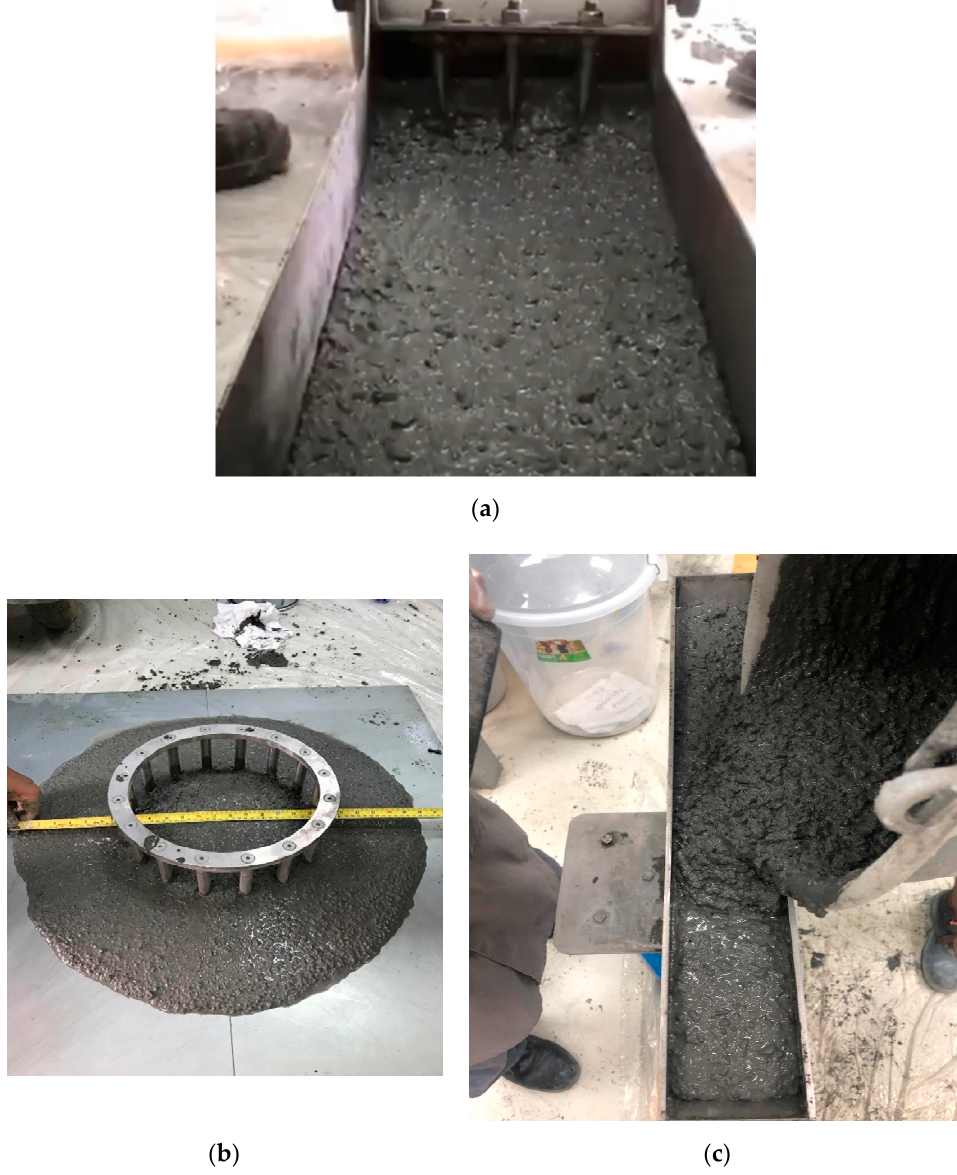
Figure 1. Photographs showing the tests performed on fresh self-consolidating concrete (SCC) samples: ( a ) Fresh SCC flowing through the L-Box; ( b ) Measuring the fresh SCC’s spread during the J-Ring test; ( c ) Filling the V-Funnel to measure viscosity.